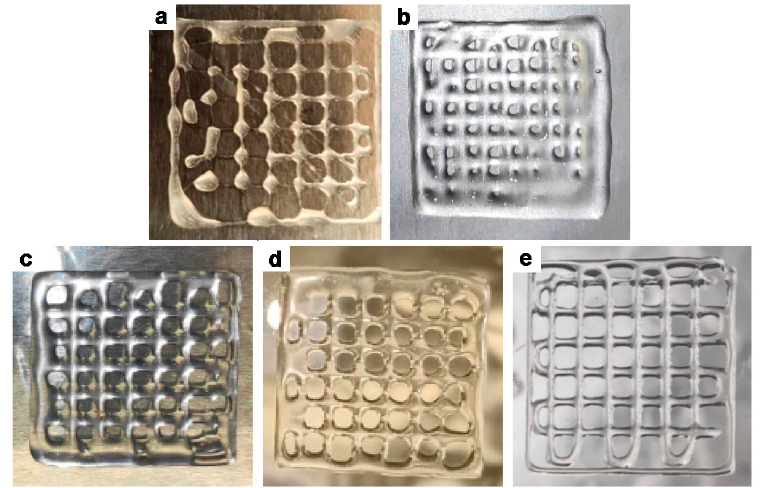
Figure 5. Photos of 3D printed ( a ) Ch solution 4%, ( b ) Ch-Pec 4–5%, ( c ) Ch-Pec 4–10%, ( d ) Ch-Pec 5–5%, and ( e ) Ch-Pec 5–10% w/v [117].